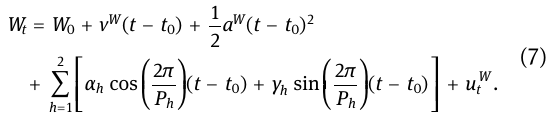
tions for equation ( 6 ) are tabulated in Table 2 under Model III. The listed estimates are all statistically signi fi -